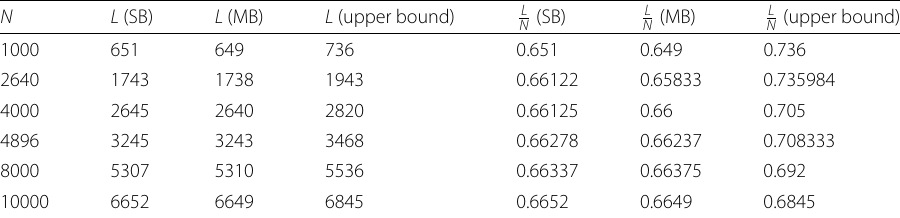
Table 1 Number of flipping function calculations for several (3,6)-regular LDPC codes over AWGN channel at SNR = 6